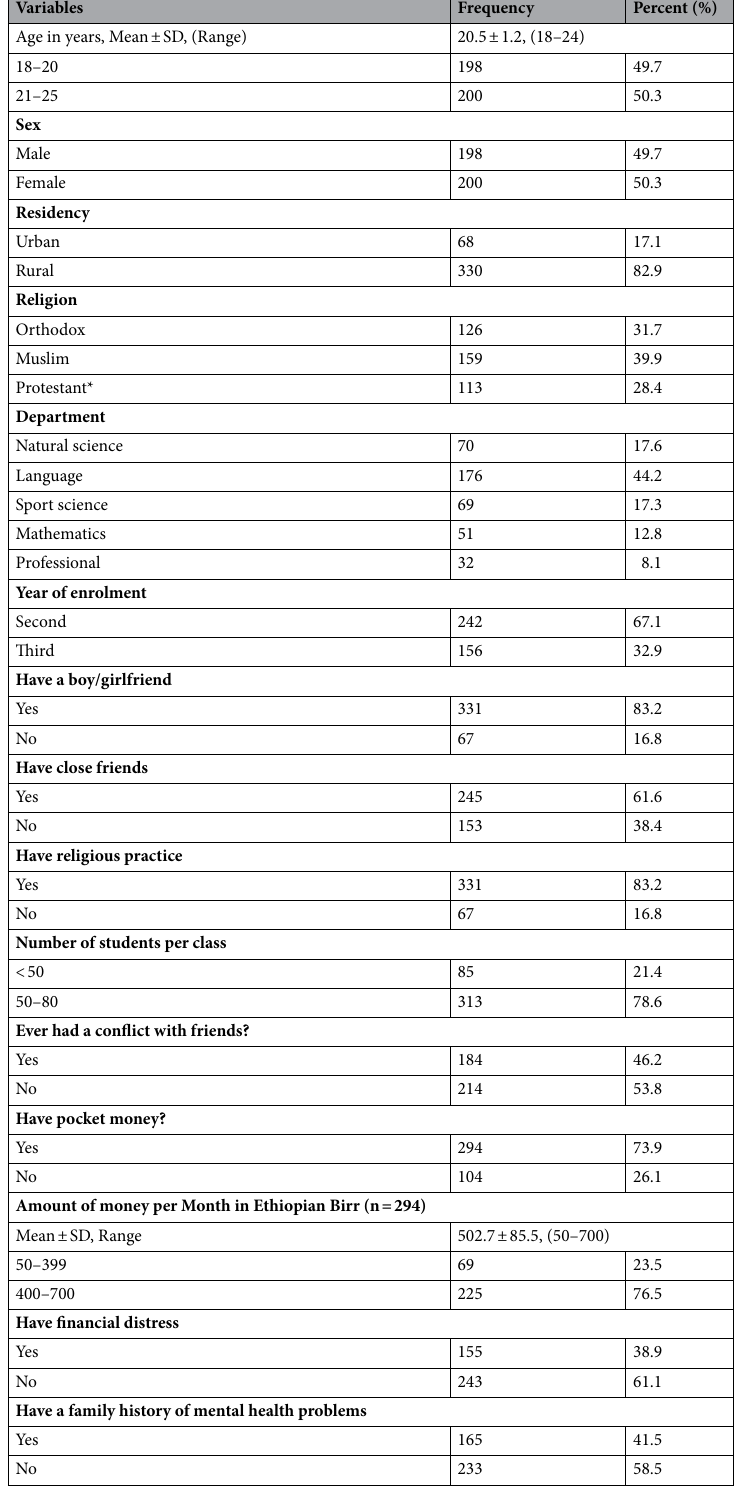
Table1. Socio-demographic characteristics of the respondents (n = 398). *One Catholic follower is